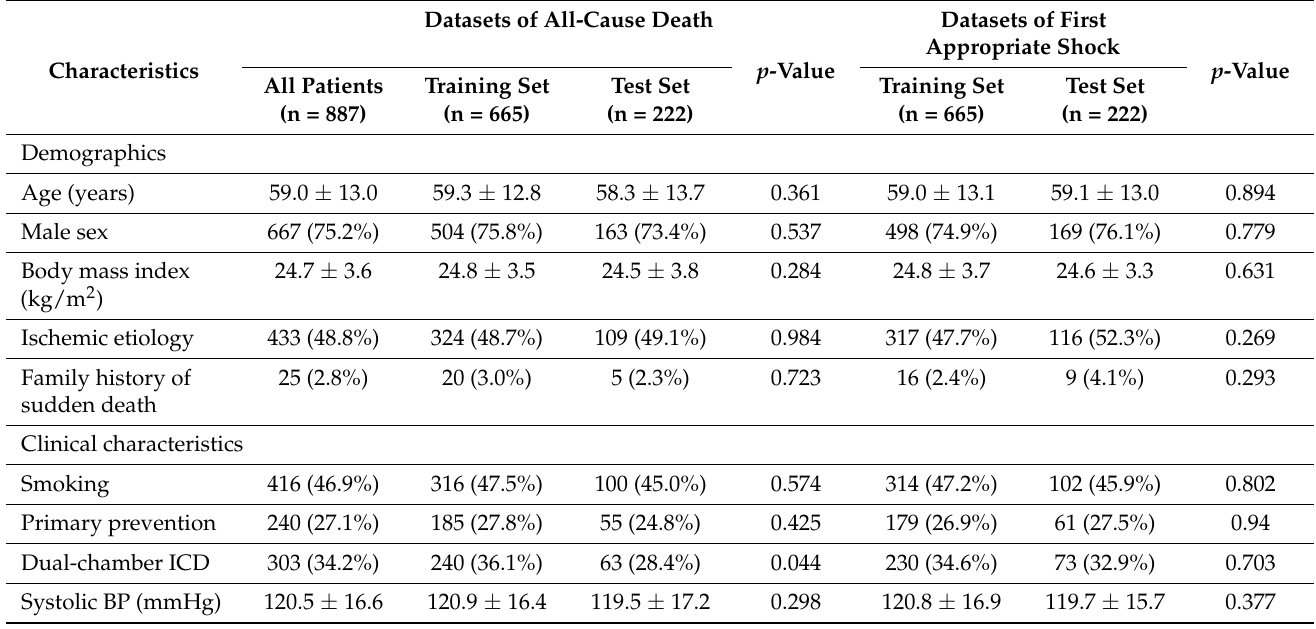
Table 1. Demographics of the training and test